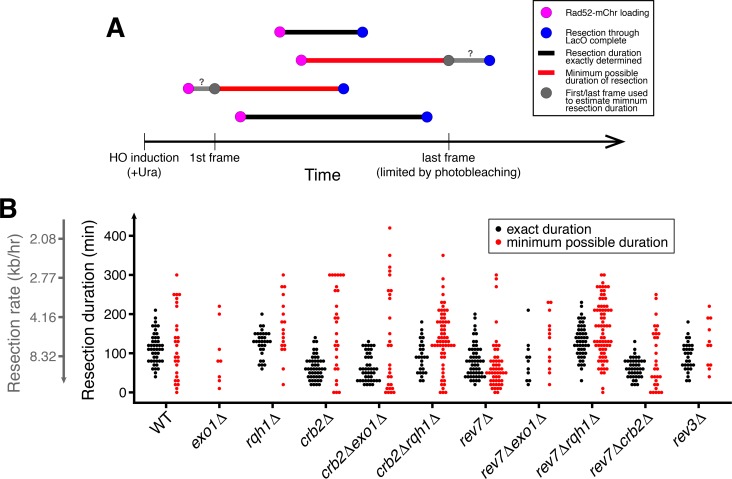
Epistasis analysis including non-exactly determined resection events.(A) Diagram of exactly and non-exactly determined resection events. The LacO resection assay is limited to 5 hr due to photobleaching. Thus, many resection events will start before the first frame or end after the last frame of data acquisition (red). Longer durations (slower resection) are more likely to extend past the first or last frame, and the lower threshold for exactly determined resection rates is 2.8 kb/hr for 5 hr of data acquisition. (B) Duration of individual resection events through the 10.3 kb LacO array (secondary y-axis shows resection rate). Minimum possible durations are shown in red. Of particular note, many slow crb2∆rqh1∆ events have longer durations (slower rates) and thus they cannot be exactly determined. See Supplementary file 2 for number of biological replicates and counts of analyzed cells.